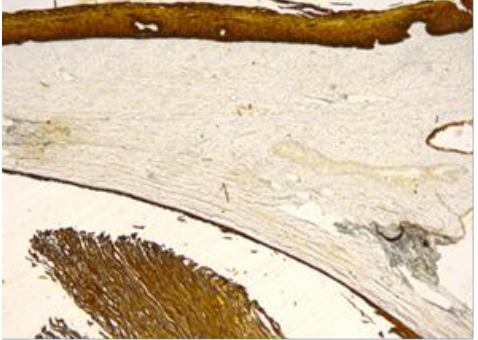
Figure 6. Cyst’s epithelium, content and overlying exocervical epithelium, marked positive (CK 5/6, 10 ×).